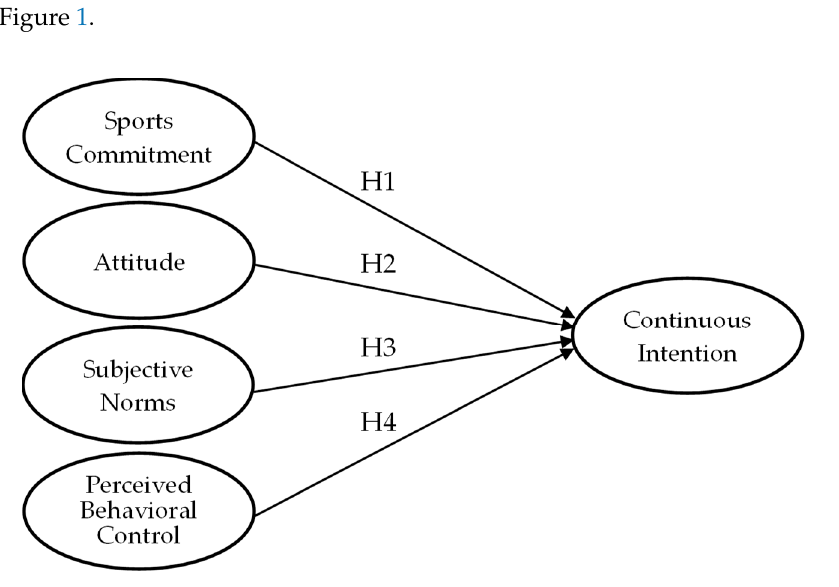
Figure 1. Conceptual model for the continuous intention of older adult participants in virtual reality sports .